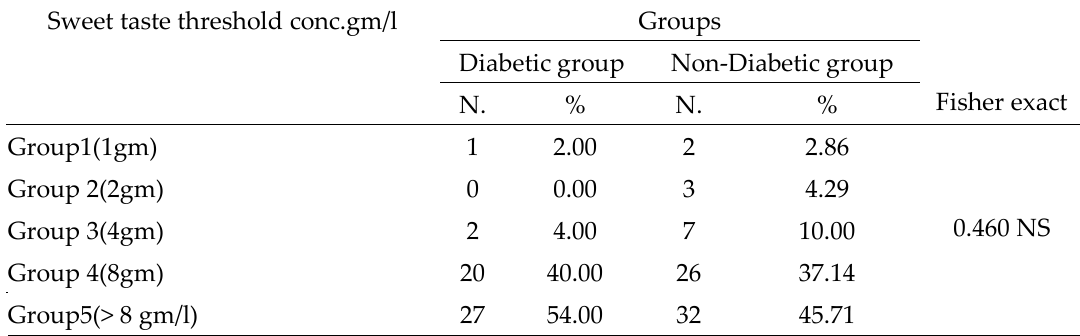
Table (2): Distribution of the sample according to sweet taste threshold Sweet taste threshold conc.gm/l